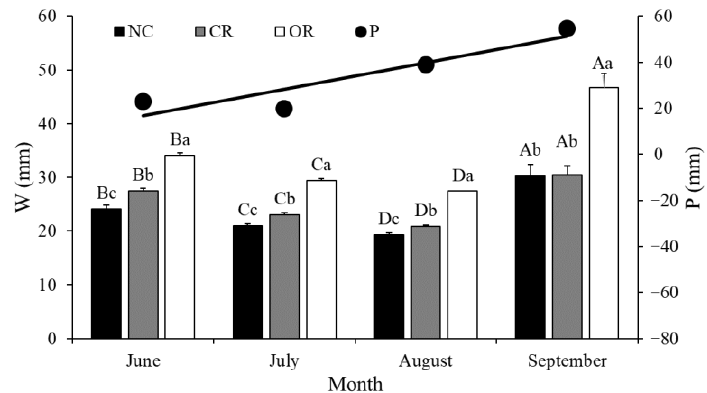
July showed the lowest value of 19.8 mm.